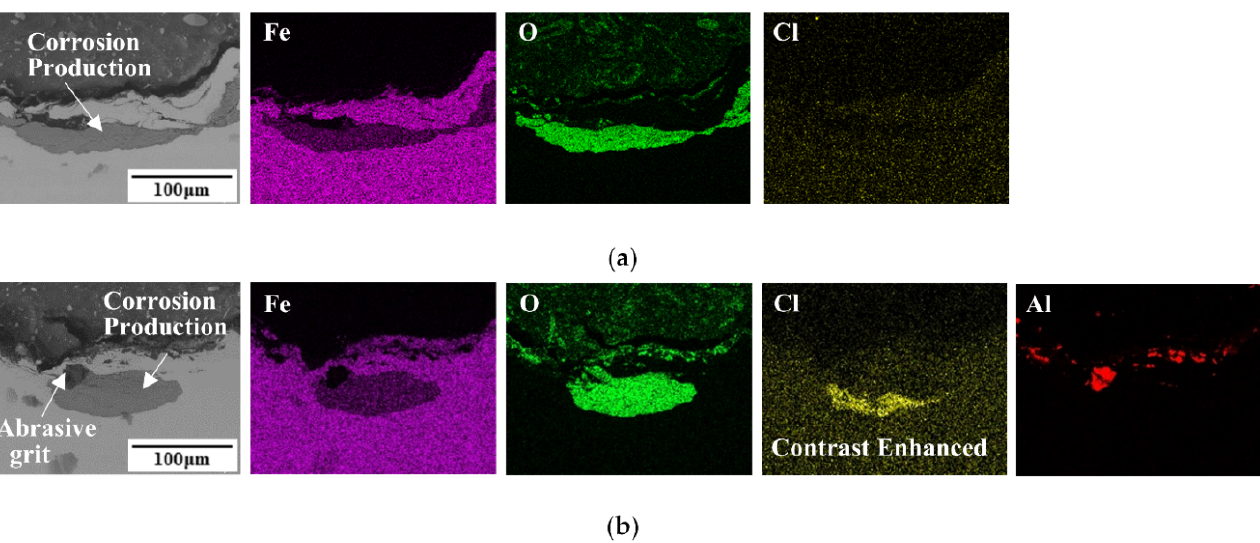
Figure 16 illustrates the state of the blasted CST and CAL surfaces after 0 and 24 h Figure 15. SEM-EDX images on the cross-section of the blasted specimens: ( a ) CST, ( b ) CAL.